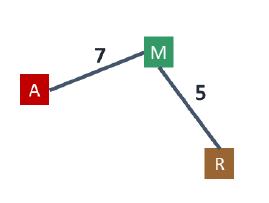
Figure 3. Auxiliary graph G C associated to the clustering C of radius r C = 5 described in Figure 2. Observe that the diameter Φ ( G ) of the original graph G (Figure 2a) is realized by the path (cid:104) L , A , E , I , M , P , Q , R , S (cid:105) of weight 16, while the algorithm returns the value Φ approx ( G ) = Φ ( G C ) + 2 · r C = 12 + 2 × 5 =